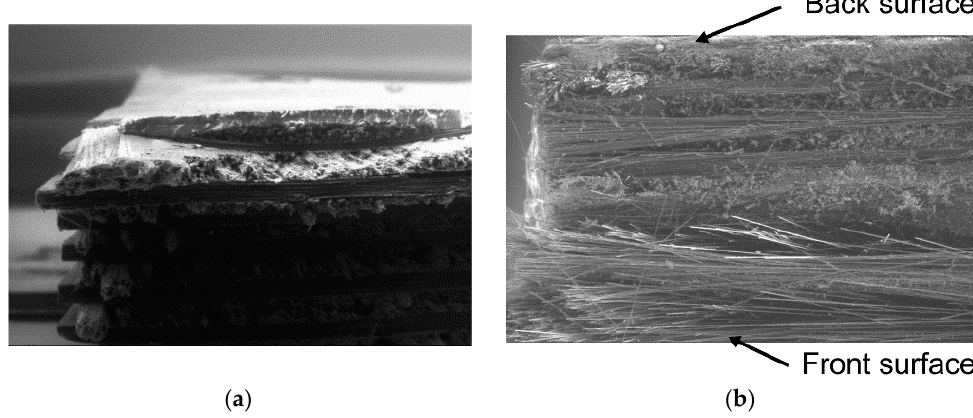
Figure 6. Scanning electron microscope (SEM) images of CFRP samples. ( a ) as-received; and ( b ) polarized sample with D failure mode.